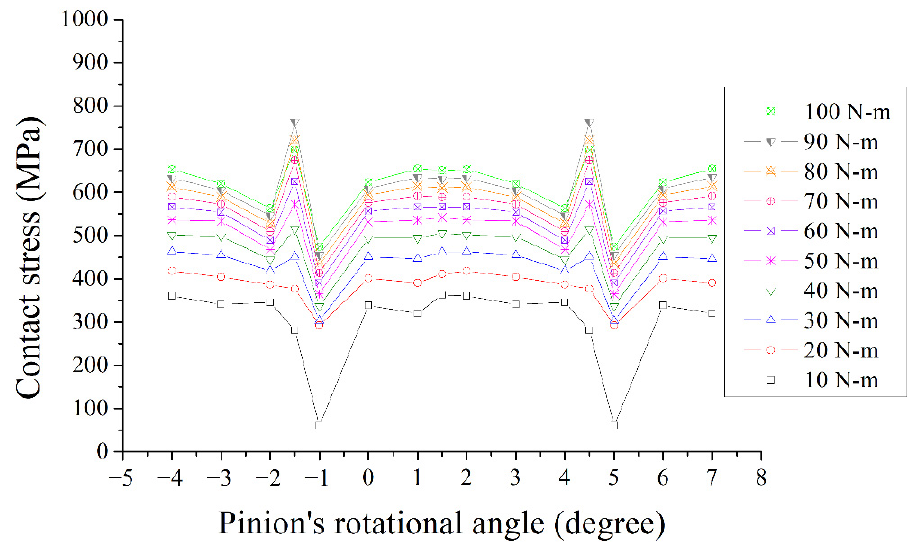
Figure 3. Contact stress under various loads.